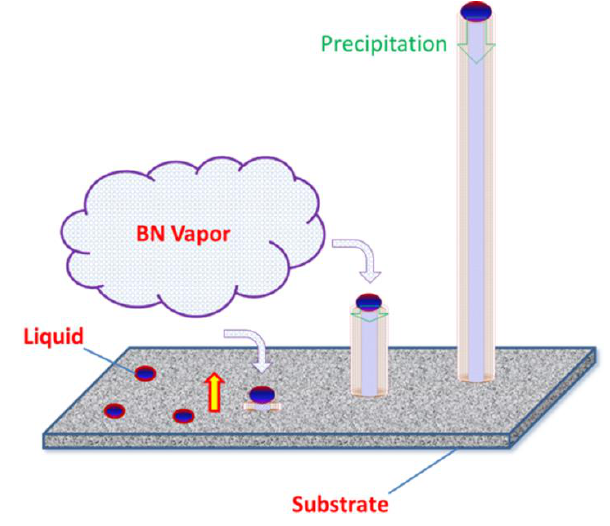
Figure 5. A schematic diagram of vapor–liquid–solid (VLS) growth for BN nanotubes.